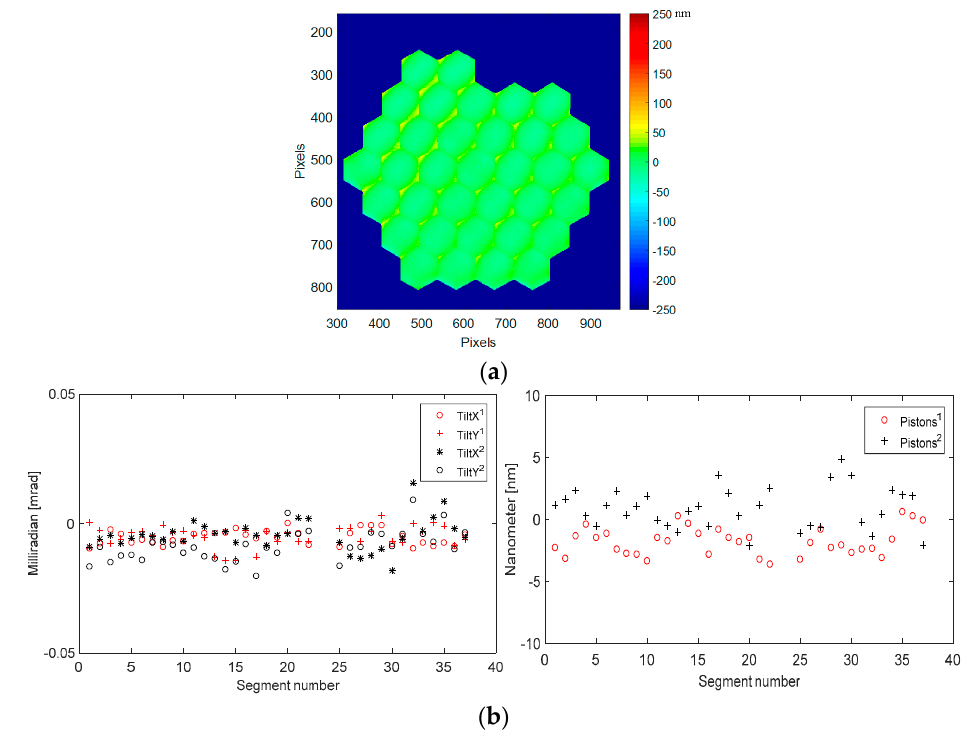
Figure 15. Mirror surface deformation at cryo (160 K), second run, when cryo best flat condition is applied: ( a ) Surface deformation map (12 nm RMS, 113 nm PtV); ( b ) Residual tilts and pistons values for each of the 37 segments of PTT111. Residual tilts with cryo best flat (red signs) are 3.5 µrad RMS (17 µrad PtV), while they were 6.5 µrad RMS (36 µrad PtV) with the improved best flat at ambient (black signs). Residual pistons with cryo best flat (red signs) are 1.2 nm rms (4.3 nm PtV), while they were 1.6 nm RMS (7 nm PtV) with the improved best flat at ambient (black signs).